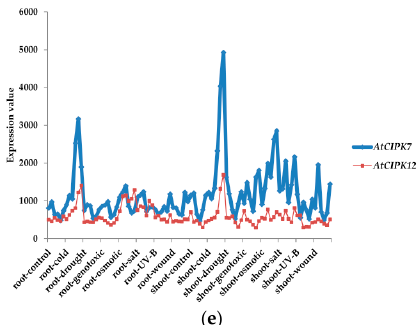
Figure 4. Expression pattern correlations of CBLs and CIPKs under different abiotic stress in shoots and roots. The expression data for each treatment were collected from TAIR database [41].